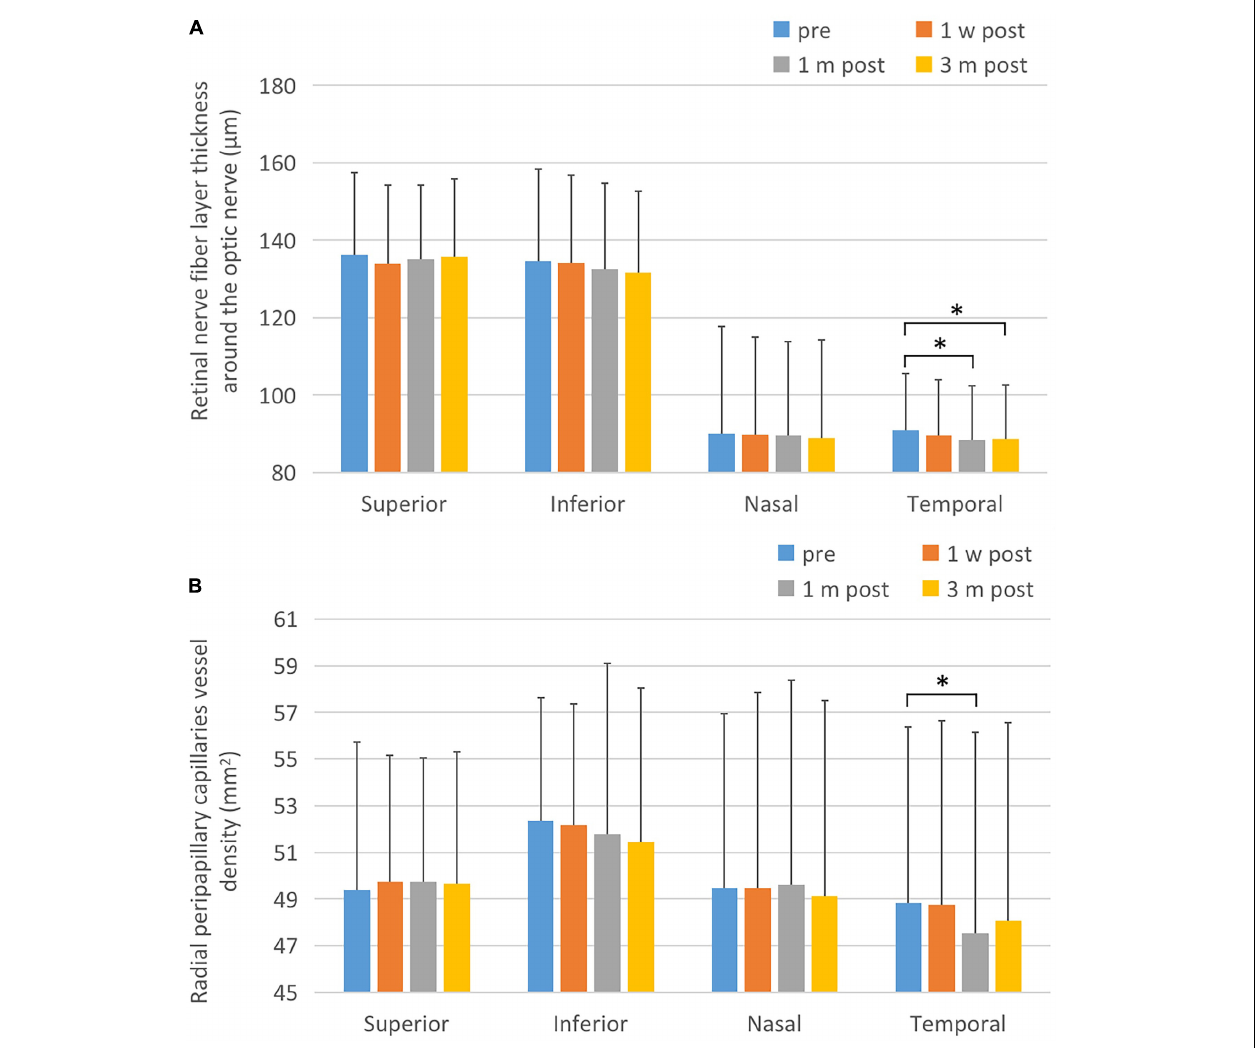
FIGURE 4 | Changes of retinal nerve fiber layer thickness and peridisk capillaries after ICL implantation. (A) Postoperative RNFL changes. The temporal RNFL thickness at 1 and 3 months after surgery was significantly reduced compared to the corresponding pre-operative values. (B) Postoperative changes of capillary density of para-optic disk. One month after surgery, the postoperative peridisk capillary density of temporal side decreased significantly lower than that pre-operatively. The short black line shows that the data at the corresponding two time points were statistically different. * P < 0.05.